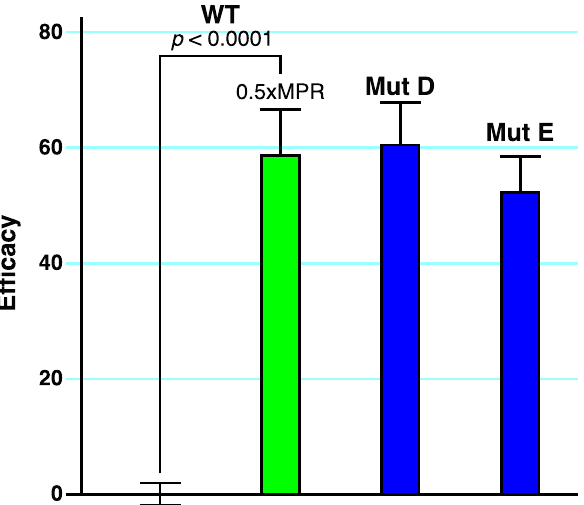
Figure 7. Comparison of the Anti-Nsp1 activity of MPR to null mutations. The efficacy of 0.5 × MPR on WT-Nsp1-transfected H1299 cells ( n = 16, p value from a two-sided t-test) is compared to the effect of established null mutations in the Nsp1 gene (Mut D and E). The concentrations of Montelukast, Ponatinib, and Rilpivirine (MPR) at the 0.5X dilution are 0.625 µM Montelukast, 0.05 µM Ponatinib, and 0.025 µM Rilpivirine. There is no significant difference in the Efficacy of 0.5xMPR-treated WT-Nsp1-transfected H1299 cells compared to the effect of null mutations in